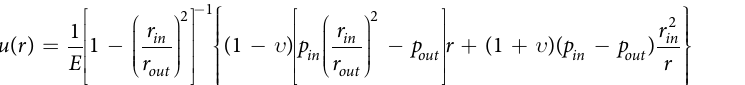
The results show that pressure-induced birefringence variations attained in embedded-core capillary fibres are similar to those achieved in sophisticated microstructured fibres. An important step towards the simplification of microstructured fibre-based pressure sensors can, therefore, be identified.